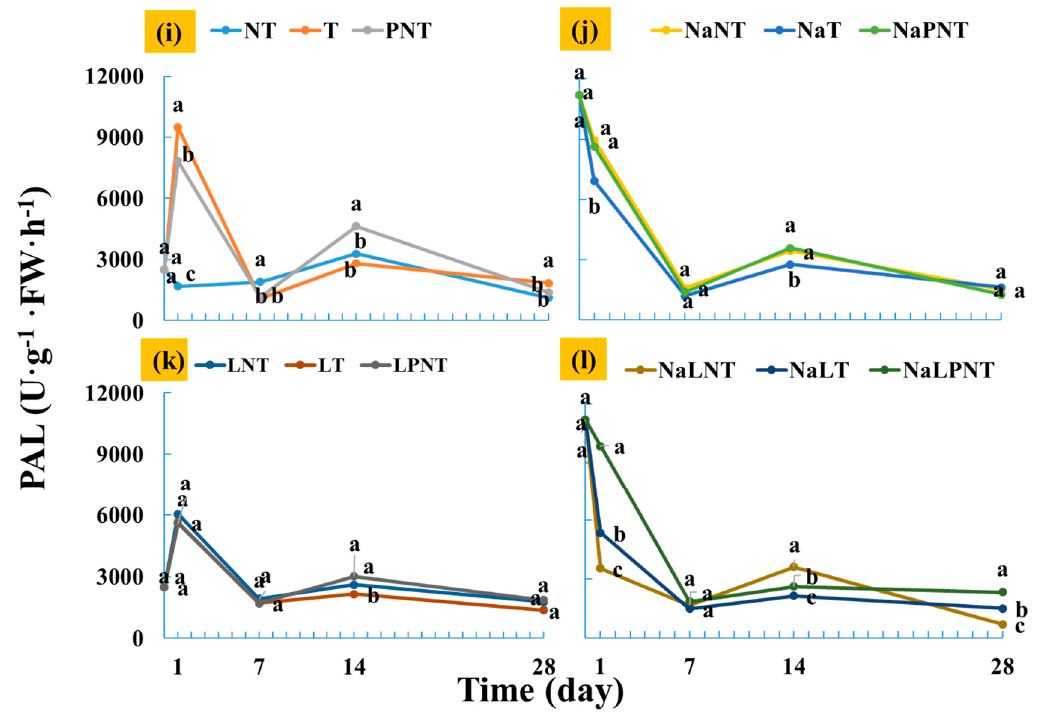
Figure 3. Total phenol contents ( a – d ), and activities of polyphenol oxidase (PPO) ( e – h ) and phenylalanine ammonia-lyase (PAL) ( i – l ) of peony petal explants. Refer to Figure 1 for details on the different denotations. Different alphabet letters indicate significant differences between treatments (ANOVA and Duncan’s test, p ≤ 0.05).